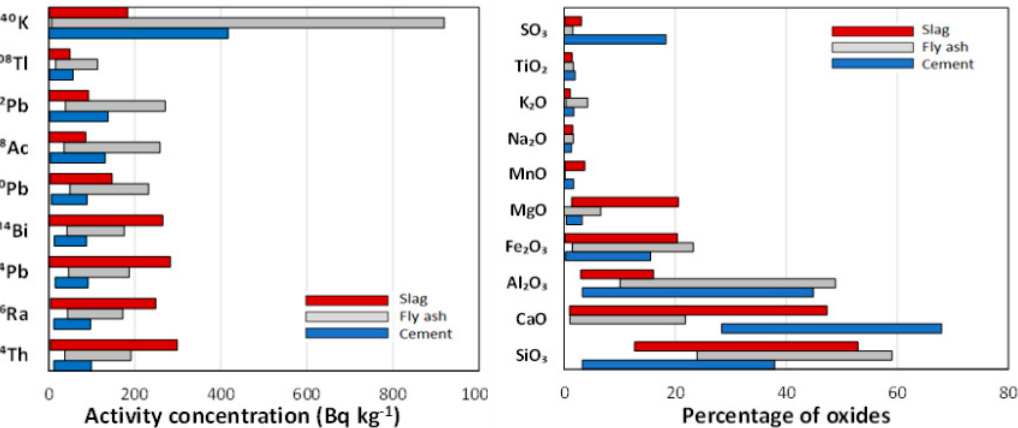
Figure 2. Activity concentration ranges of the radionuclides belonging to the natural radioactive series of uranium ( 234 Th, 226 Ra, 214 Pb, 214 Bi, and 210 Pb) and thorium ( 228 Ac, 212 Pb, and 208 Tl) together with the 40 K, and chemical composition (in percentage of oxides) for the cements, FA and S analyzed in this study. The actinium ( 235 U) series was not represented as all activity concentrations were below the lower limit of detection (LoD).